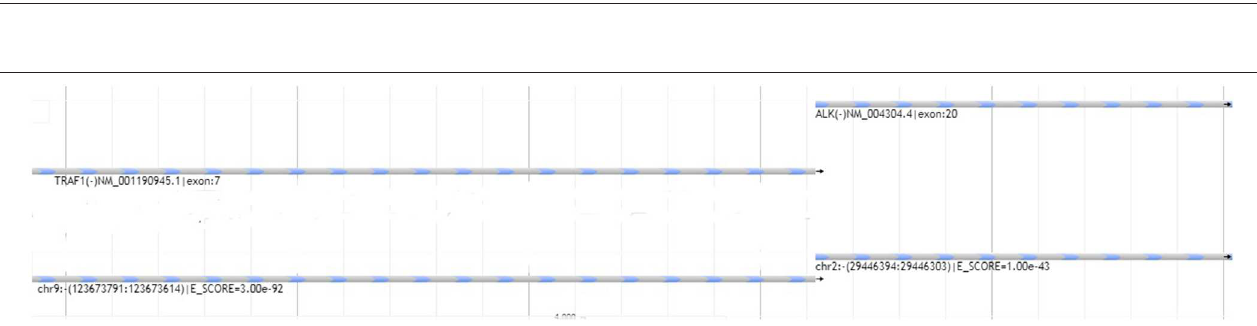
FIGURE 2 | Graphical representation of next-generation sequencing translocation analysis. Reads aligned with exon 20 of ALK1 were found to be adjacent with reads aligned with exon 7 of the TRAF1 gene. E-score represents a confidence score whereby lower values reflect higher confidence of sequence alignment in the reads.